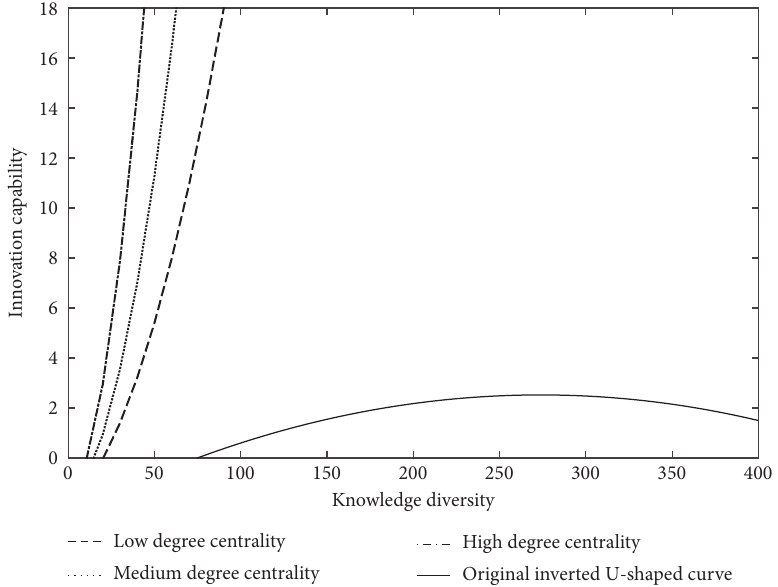
Figure 7: Effect of knowledge diversity and interaction effect between knowledge diversity and degree